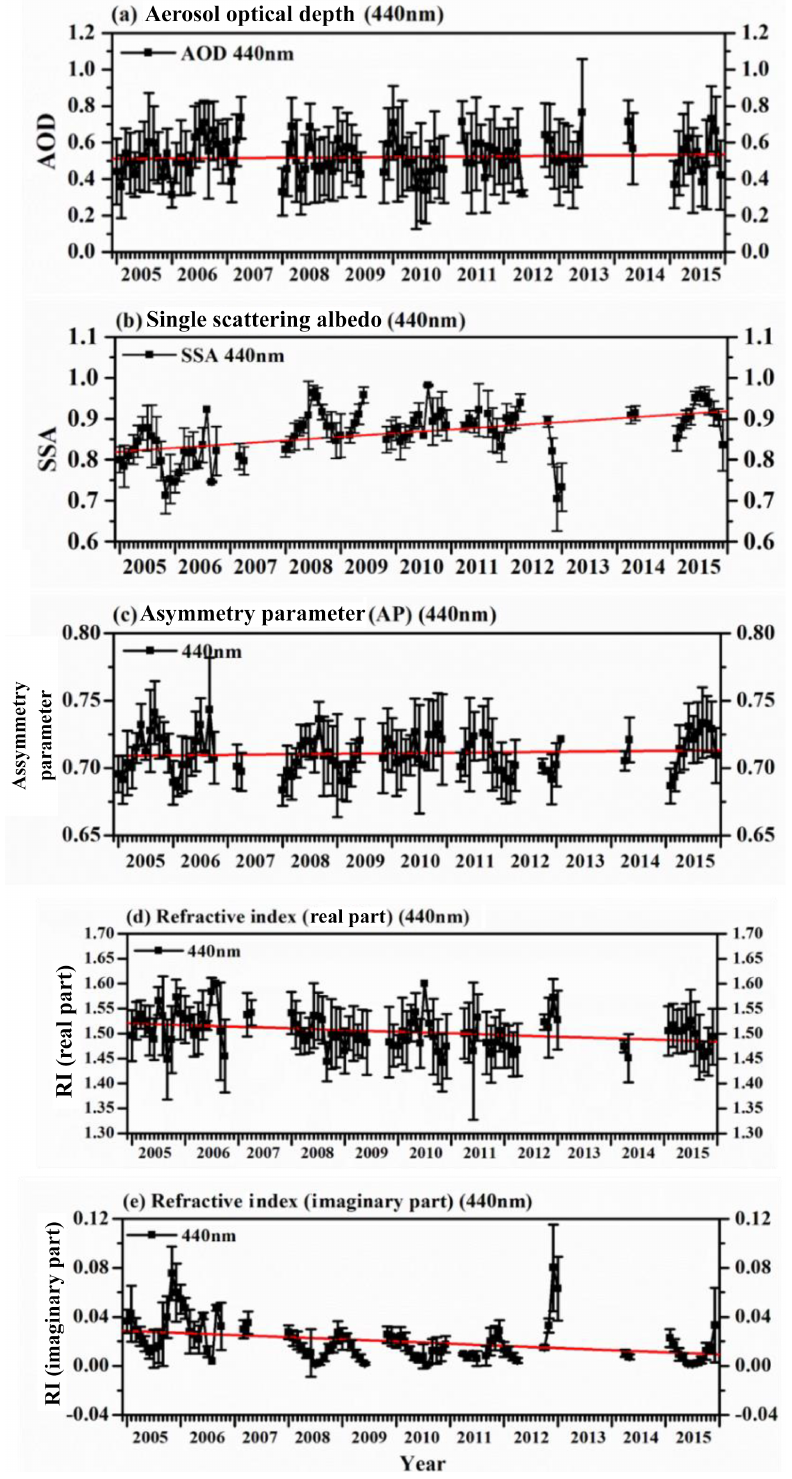
Figure 9. Long-term trends in aerosol products at